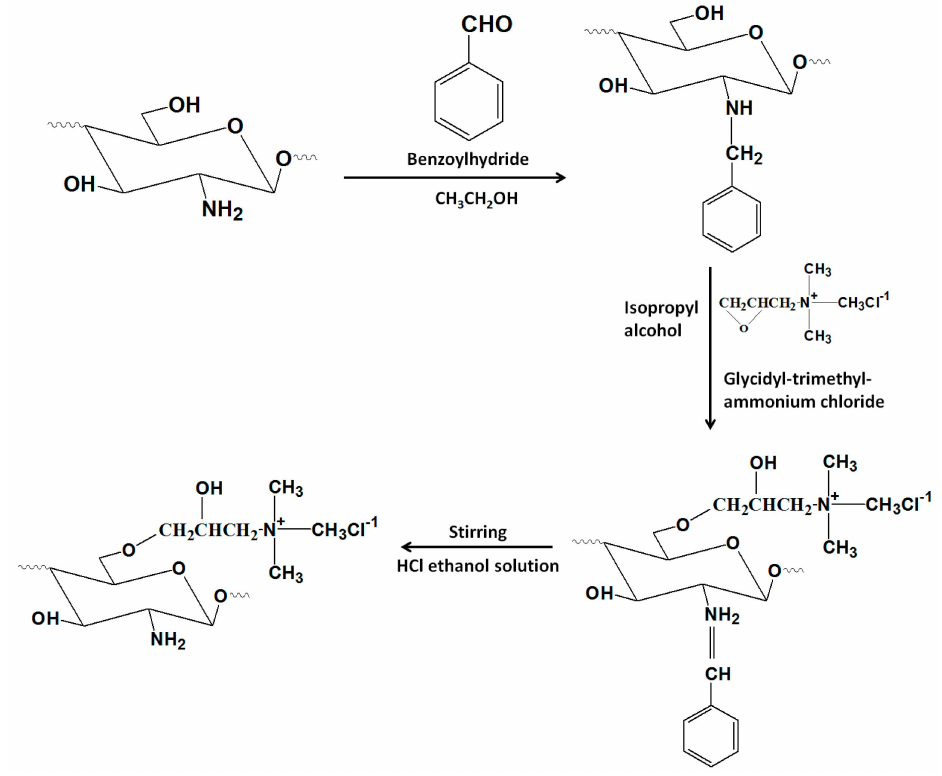
Figure 14. Schematic representative of preparation of O -(2-hydroxyl)propyl-3-trimethylammonium chitosan chloride